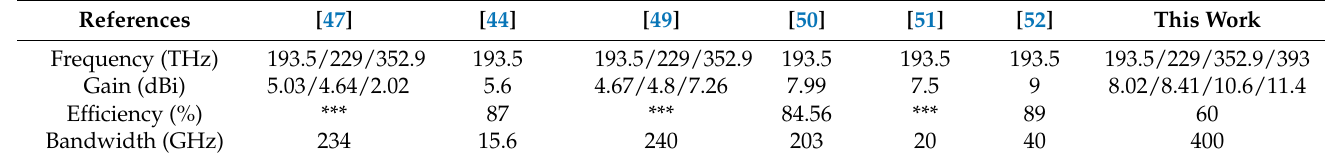
Table 2. Comparison of the proposed antenna with the existing